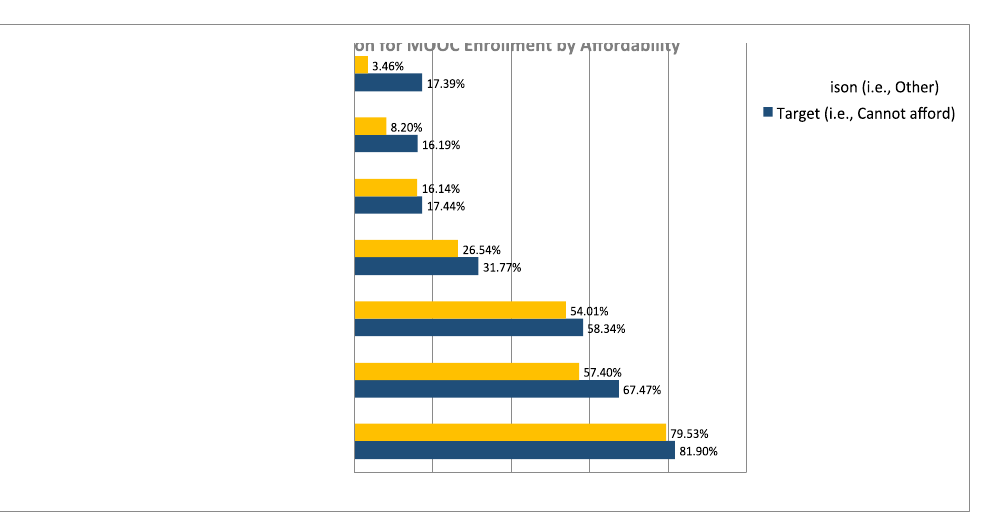
Figure 1 . Additional motivations of learners based on